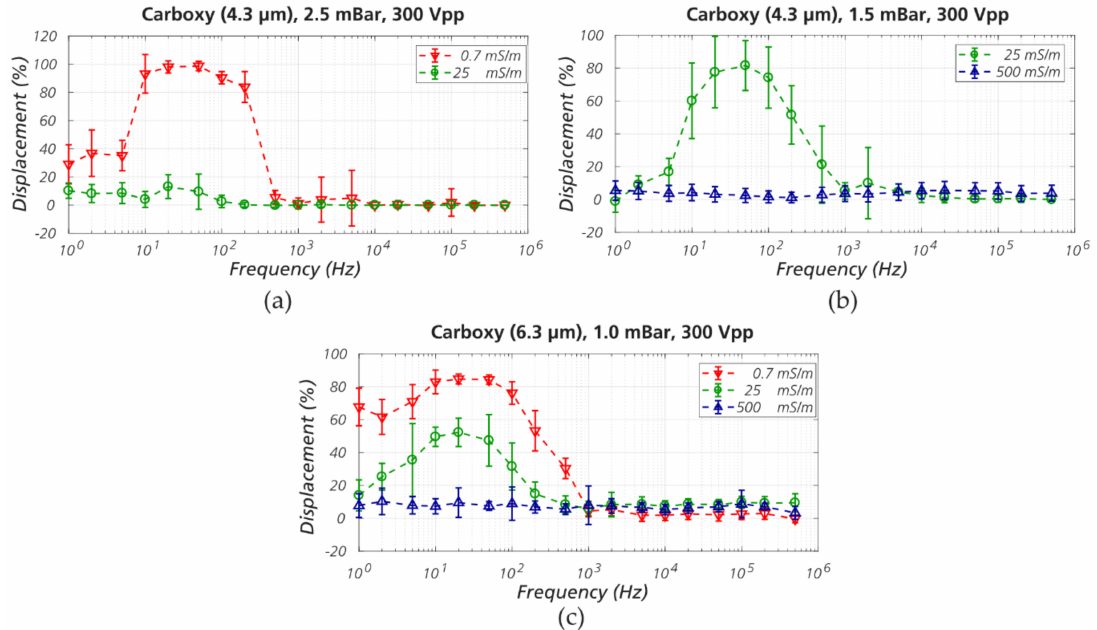
Figure 3. E ff ects of medium conductivity and voltage frequency on displacement of beads in eDLD. ( a , b )The4.3 µ mbeadsindevice#5( D C = 6.0 µ m)at2.5mBarand1.5mBar, respectively. Thedisplacement is strongest at frequencies between 10 and 500 Hz, and at low electrical conductivity of the medium. ( c ) The 6.3 µ m beads in device #6 ( D C = 8.4 µ m). The displacement is strongest at frequencies between 10 and 500 Hz, and at low